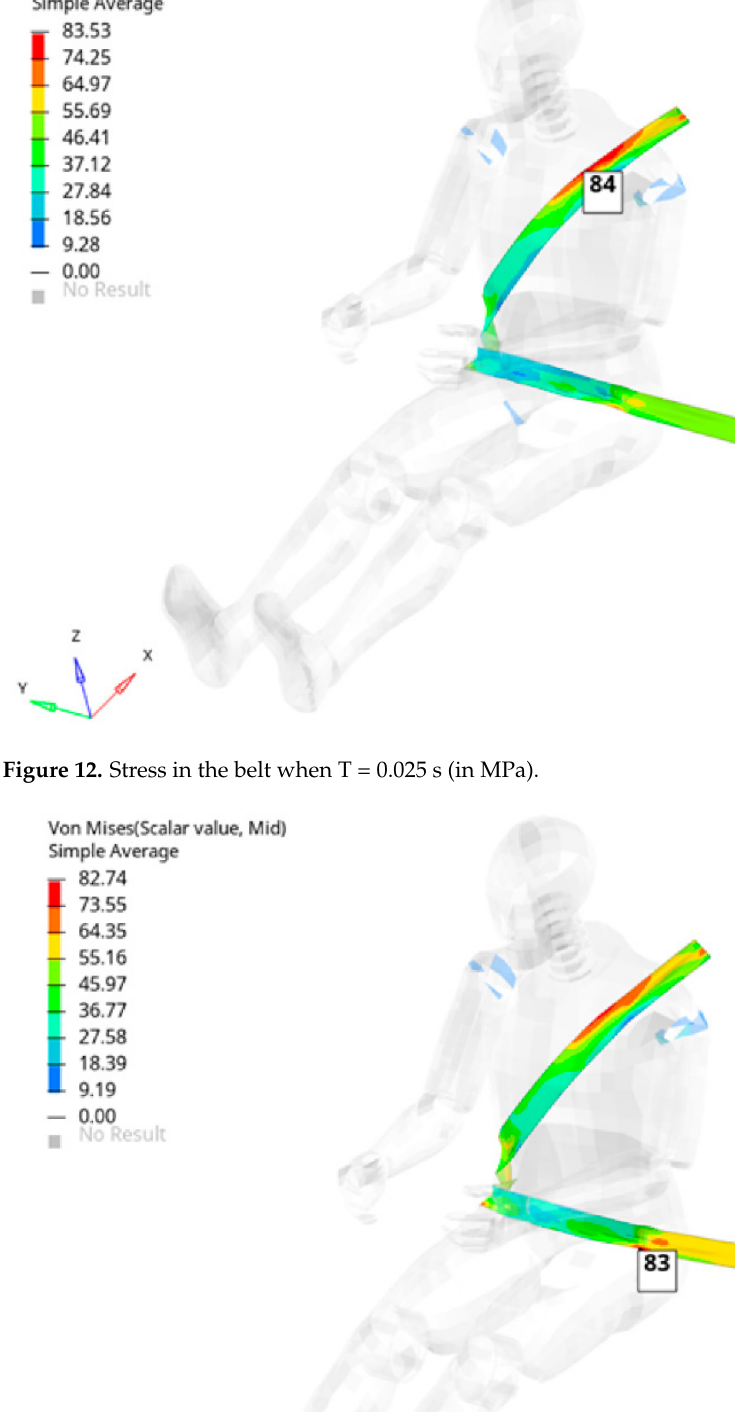
Figure 11. Stress in the belt when T = 0.020 s (in MPa).